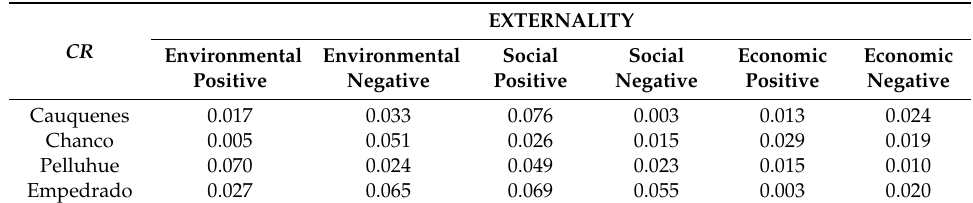
Table 5. Consistency Ratios for the individual municipalities.